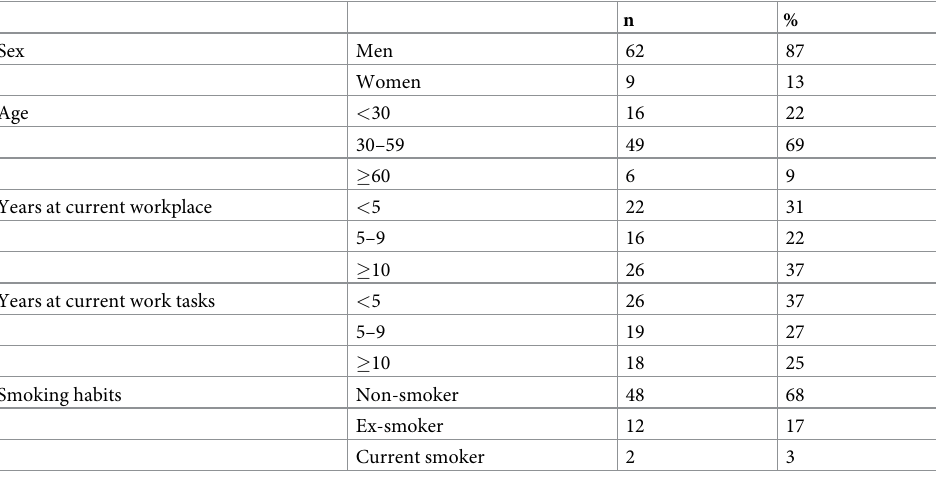
Table 1. Base characteristic for the study population (n = 71) a